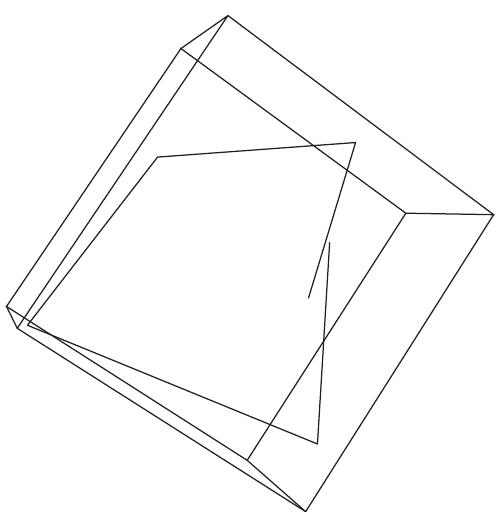
Figure 3: The Kahan integrator of the system (1), projection on